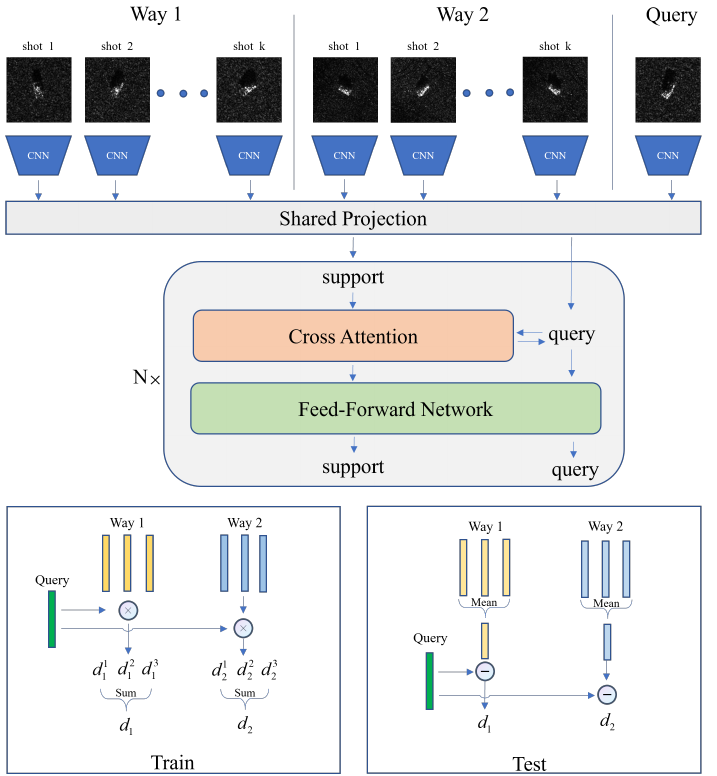
Figure 3. The overall architecture of the proposed IAT. The example here is a 2-way k-shot